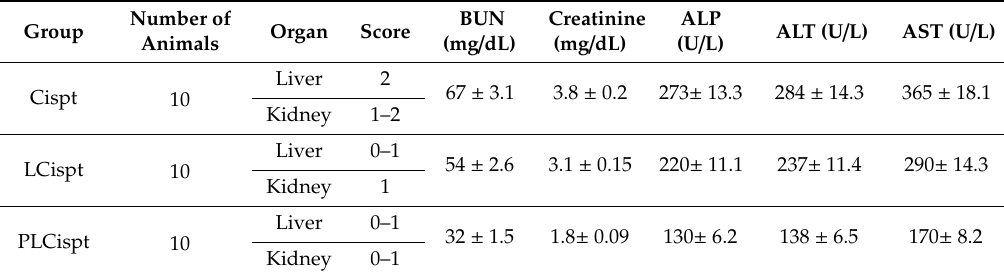
Figure 8. Weight changes in the BC tumor-bearing rats receiving various formulations (control, PBS, Cispt, LCispt, and PLCispt) compared to the healthy control group. The bodyweight gain (BWG) was lower in the standard Cispt rats compared to PLCispt receiver group (3% versus 10%). Statistical analyses were performed using one-way ANOVA and F-tests with * p < 0.05. The data are expressed as mean ± SD ( n = 3). Table 3. Histological evaluation of organ toxicity after treatment with Cispt, LCispt, and PLCispt, and the serum concentrations of blood urea nitrogen (BUN), creatinine, alanine transaminase (ALT), alkaline phosphatase (ALP), and aspartate transaminase (AST) in these groups of